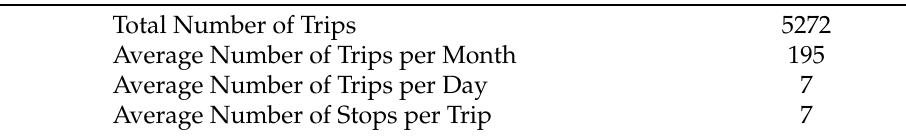
Table 2. Summary of NextUp-1 Data Set.